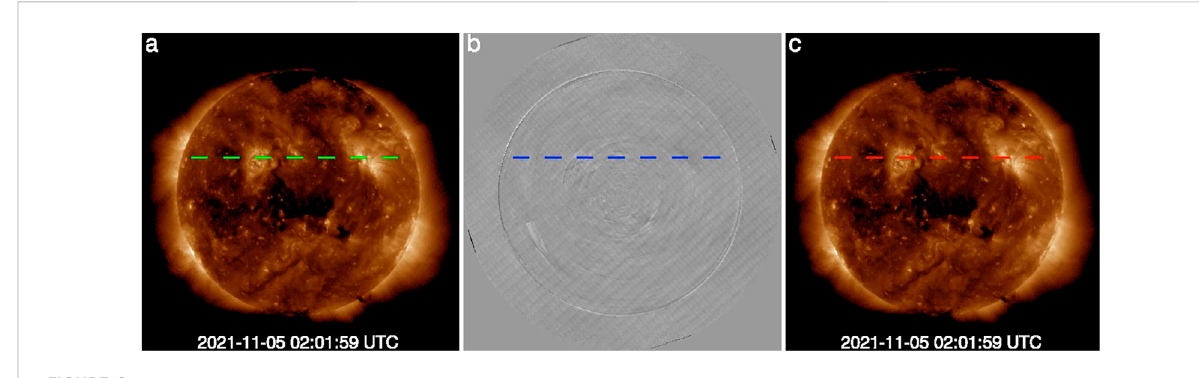
FIGURE 6 Original solar image (A) , fl at- fi eld matrix (B) , and the corrected image (C) . The solar image was captured by X-EUVI at 02: 01 on 05 November